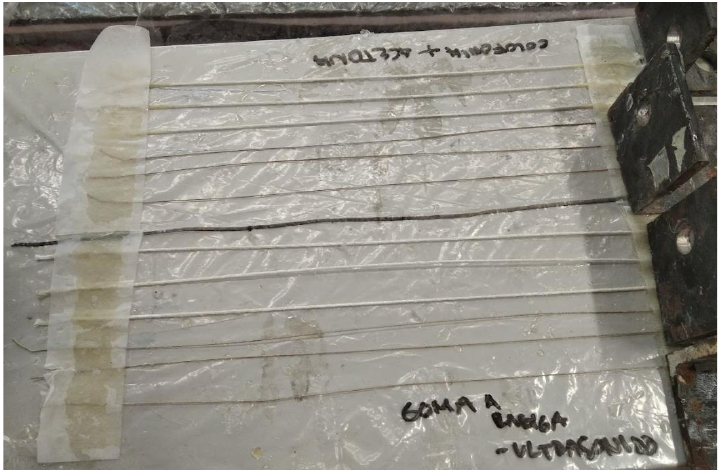
Figure 1. Preparation of the yarns.